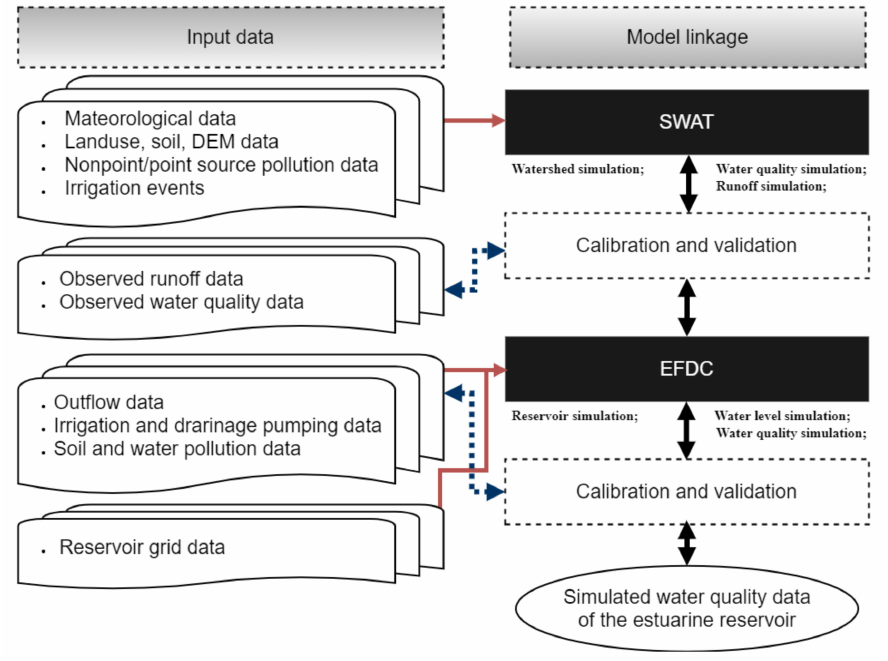
Figure 2. Diagram of SWAT-EFDC linkage model for the estuarine reservoir